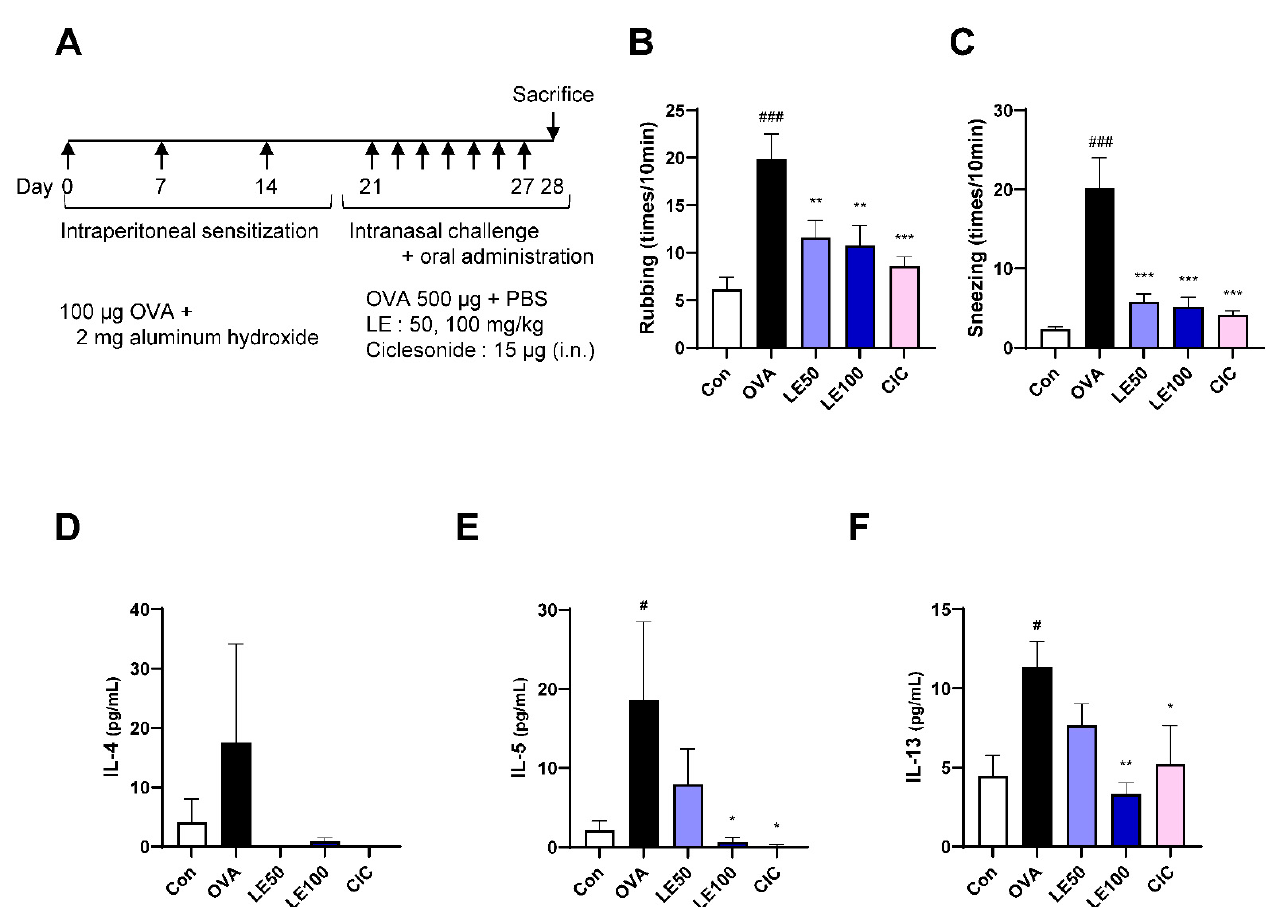
Figure 1. Effects of LE on nasal symptoms and allergic inflammation in mice with OVA-induced allergic rhinitis (AR). ( A ) Experimental protocol. ( B , C ) After the last intranasal administration of OVA, nasal rubbing ( B ) and sneezing ( C ) were measured for 10 min. Oral administration of LE (50 or 100 mg/kg) and intranasal challenge with CIC significantly decreased levels of allergy-associated cytokines in NALF. ( D – F ) Using ELISA, the levels of IL-4 ( D ), IL-5 ( E ), and IL-13 ( F ) in NALF were determined. Values represent the mean ± SEM ( n = 10 per group). Significant differences with # p < 0.05, ### p < 0.001 versus the control group. * p < 0.05, ** p < 0.01, *** p < 0.001 versus the OVA group.